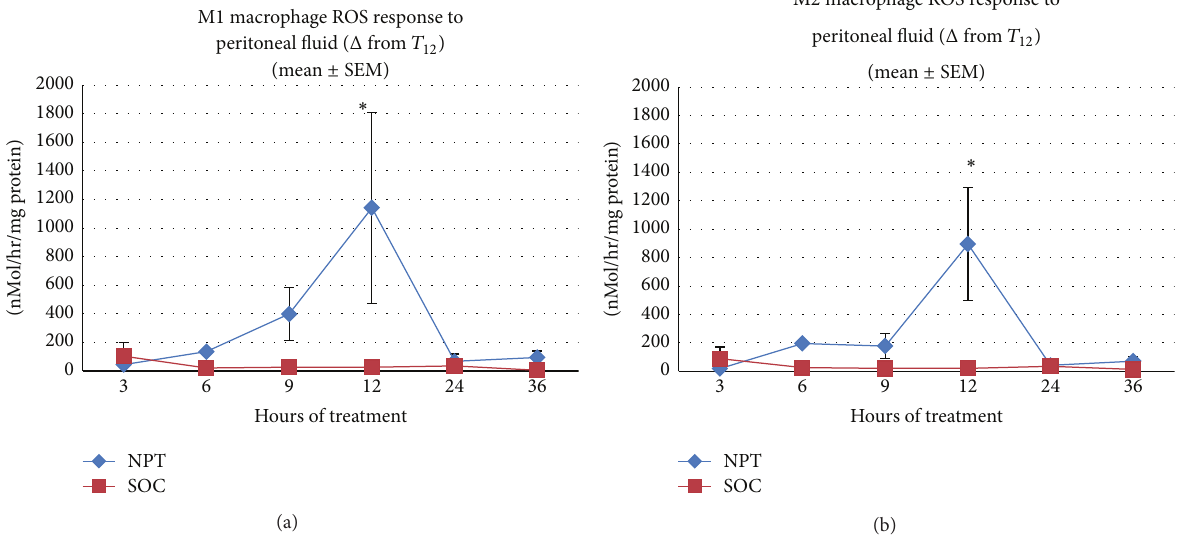
Figure 4: Production of ROS by M1 and M2 macrophages in response to peritoneal fluid (PF) from septic swine in vitro . The production of ROS by human macrophages was induced in vitro with PF taken from swine at various intervals following the induction of septic injury, and the results are expressed as the difference ( Δ ) from the initiation of treatment at the 12hrs interval ( 𝑇 12 ), representing a 36 hrs period of treatment. (a) PF from NPT-treated septic swine induced a significant inflammatory response (mean change in nMol/hour/mg protein ± SEM from baseline) in M1 macrophages than PF from SOC-treated septic swine, peaking at 12 hrs after the initiation of treatment ( ∗ 𝑝 = 0.019 ). (b) PF from NPT-treated septic swine induced a greater inflammatory response (mean change in nMol/hour/mg protein ± SEM from baseline) in M2 macrophages than PF from SOC-treated septic swine, peaking at 12hrs after the initiation of treatment ( ∗ 𝑝 = 0.085